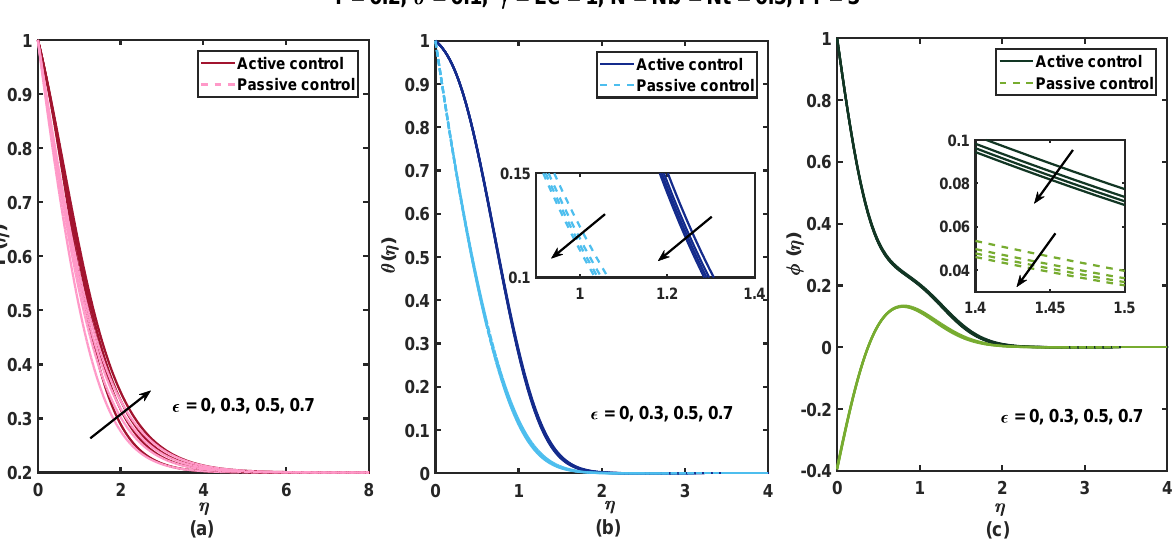
Figure 3. Impact of fluid parameter (cid:101) on ( a ) velocity, ( b ) temperature, and ( c ) nanoparticle volume fraction